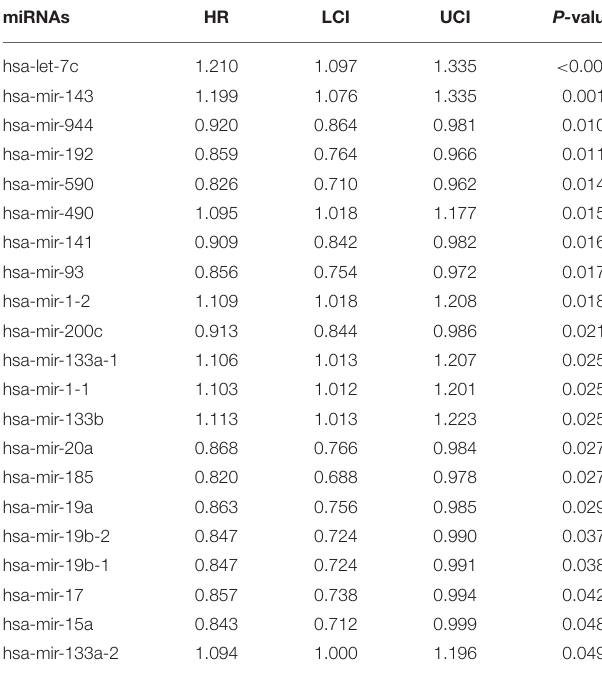
TABLE 1 | Univariate Cox proportional hazards regression analysis of 21-miRNA signature for bladder cancer. miRNAs